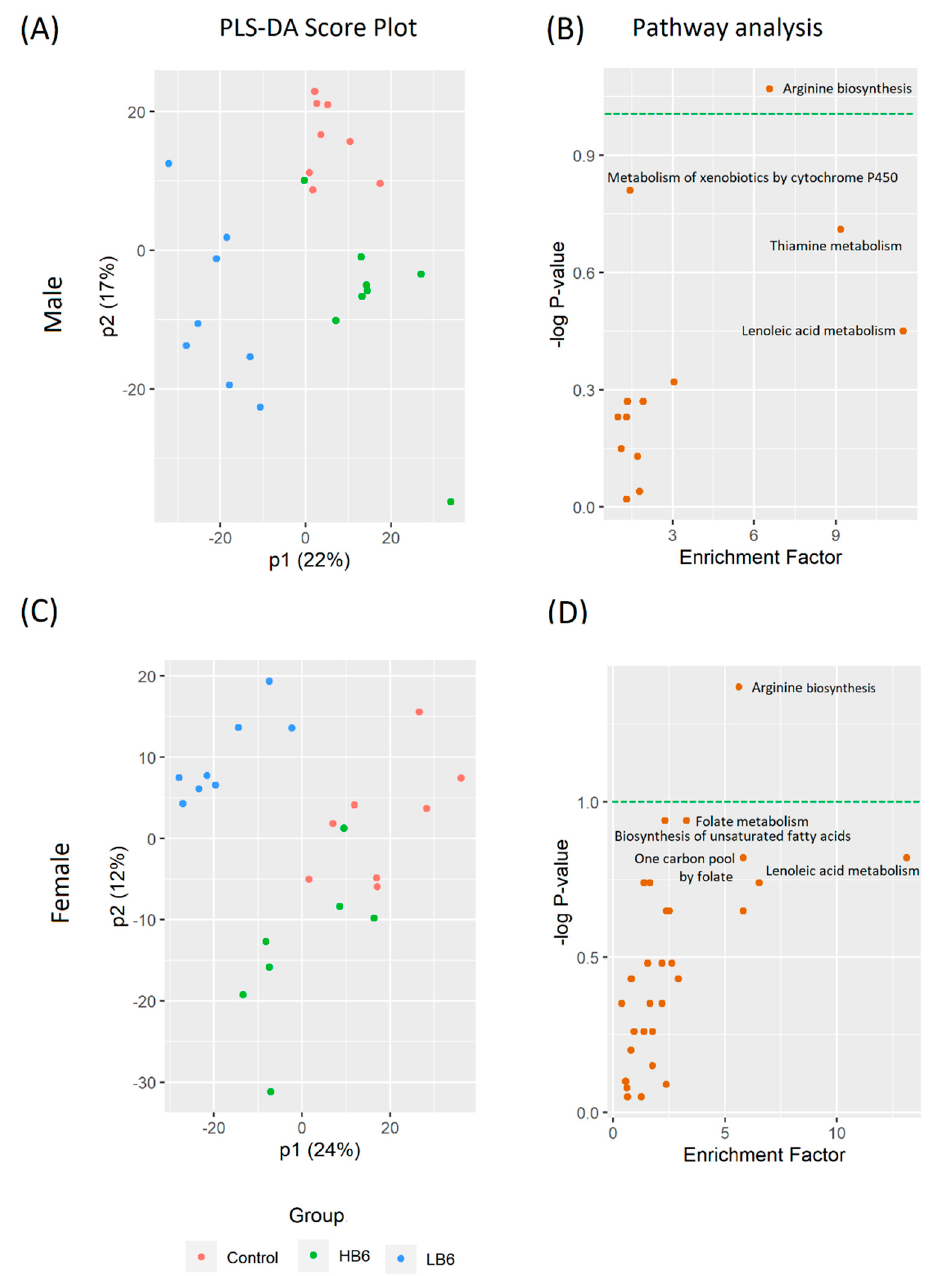
Figure 4. Cecal metabolites that di ff er in LB6 rats compared to control and HB6 rats ( n = 8 / group). Partial least square-discriminant analysis (PLS-DA) score plot for male ( A ) (R2Y = 0.676, Q2Y = 0.425, p < 0.05) and female ( C ) R2Y = 0.671, Q2Y = 0.408, p < 0.05) metabolites with their corresponding a ff ected metabolic pathways modulated in LB6 male ( B ) and female ( D ) rats compared to the control. n = 7–8 / group of each sex.